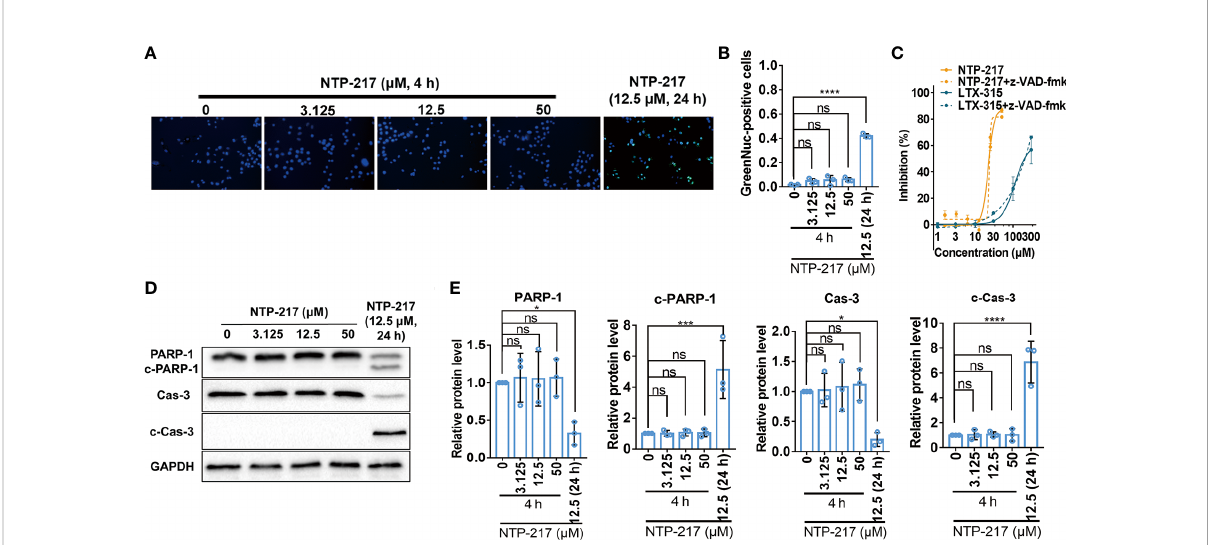
FIGURE 3 Failure of NTP-217 to induce caspase-3 activation and apoptosis. (A) Hepa 1-6 cells were treated with different concentrations of NTP-217 for 4 h or with 12.5 m M NTP-217 for 24 h. Cells were stained with a caspase-3/7 assay kit and Hoechst 33258 (objective magni fi cation, x4). (B) Quanti fi cation of apoptotic cells by counting the ratio of GreenNuc-positive and Hoechst 33258-positive cells. (C) Hepa 1-6 cells were incubated with NTP-217 alone or in the presence of 20 m M z-VAD-fmk for 4 h and then subjected to MTT assay. (D) PARP-1, cleaved PARP-1, caspase-3 and cleaved caspase-3 expression was measured using western blot analysis in Hepa 1-6 cells treated with NTP-217 for 4 or 24 h. (E) Quanti fi cation of PARP-1, cleaved PARP-1, caspase-3 and cleaved caspase-3 expression. Data are presented as the mean ± SD (n=3).